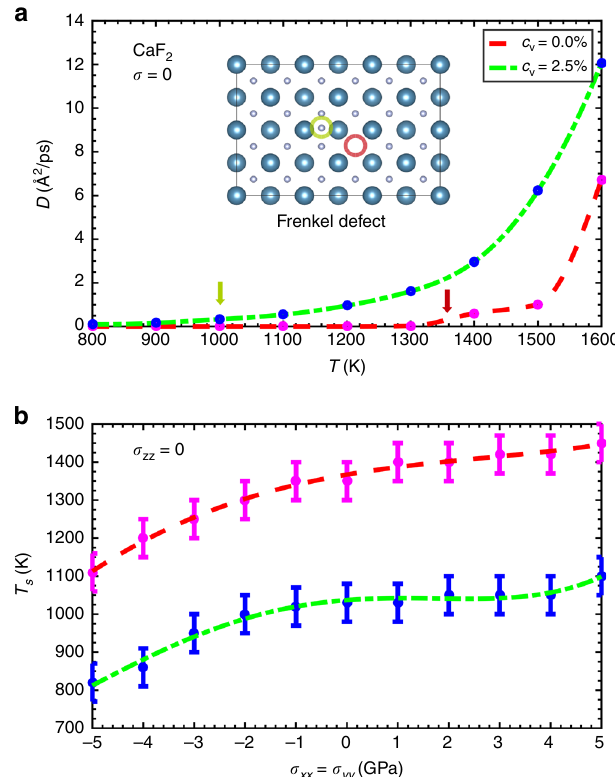
Fig. 1 Effects of vacancies on the ionic conductivity of type-II thin fi lms. a F − diffusion coef fi cient in perfect and defective ( c v = 2.5%) calcium fl uoride expressed as a function of temperature. The creation of a Frenkel pair defect, the fundamental atomistic mechanism for superionic transport in type-II FIC, is sketched. Red and green arrows indicate the critical superionic transition in the perfect and defective systems. b Critical superionic temperature expressed as a function of biaxial stress in perfect and defective CaF 2 . The lines are guides to the eye and the error bars in